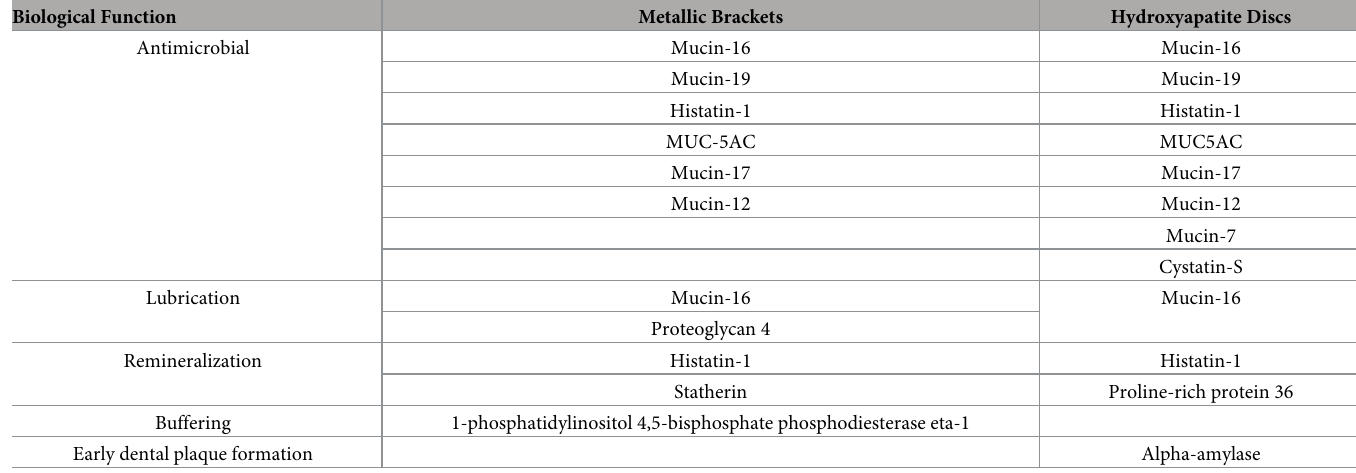
Table 3. Proteins identified in the pellicle formed on metallic brackets and on hydroxyapatite discs categorized by biological function related to dental caries. Biological